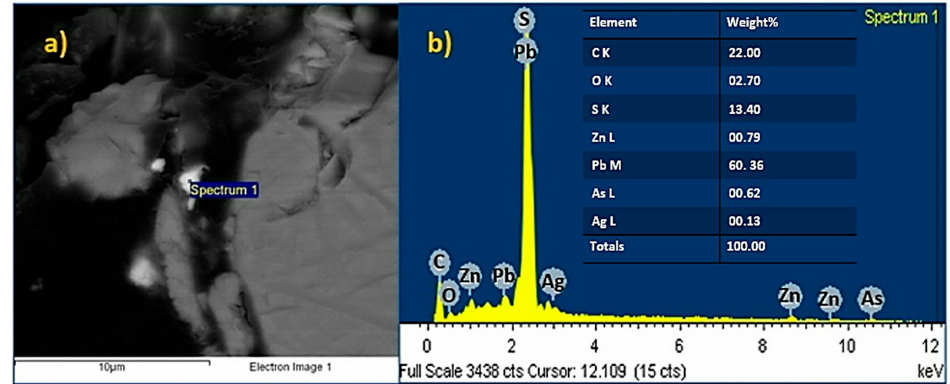
Figure 2. ( a ) Backscattered electron micrograph performed on a particle less dense than the Zn concentrate matrix. ( b ) Energy Dispersive X ‐ ray Spectrum performed on a particle less dense than the Zn concentrate matrix.